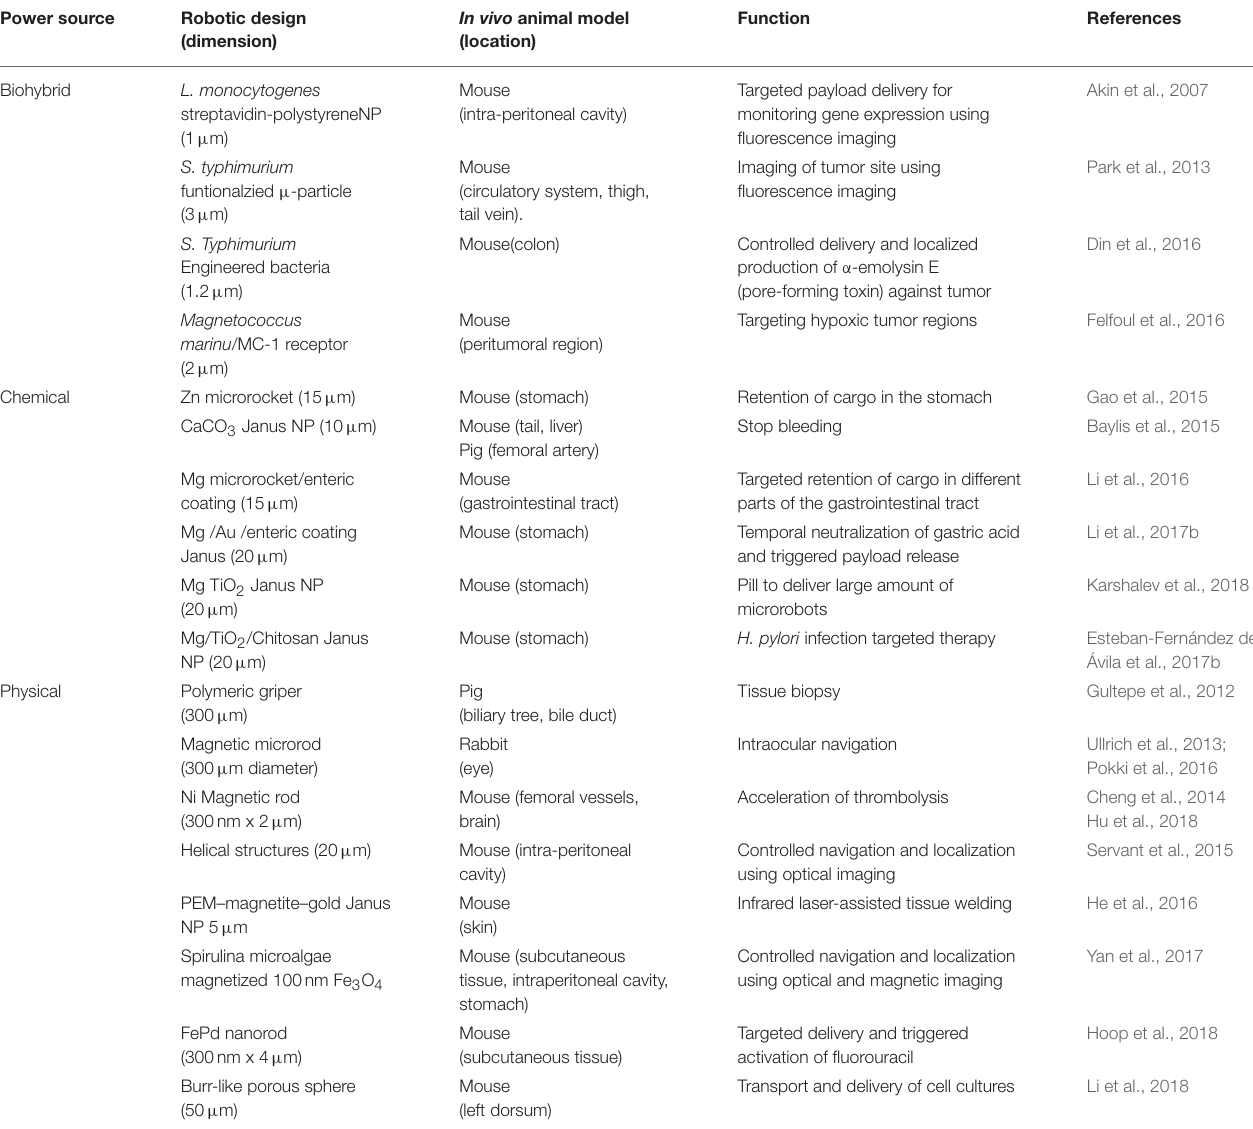
TABLE 1 | In-vivo applications of micro/nanorobots divided into the power source, robotic design, animal model, and function. Power